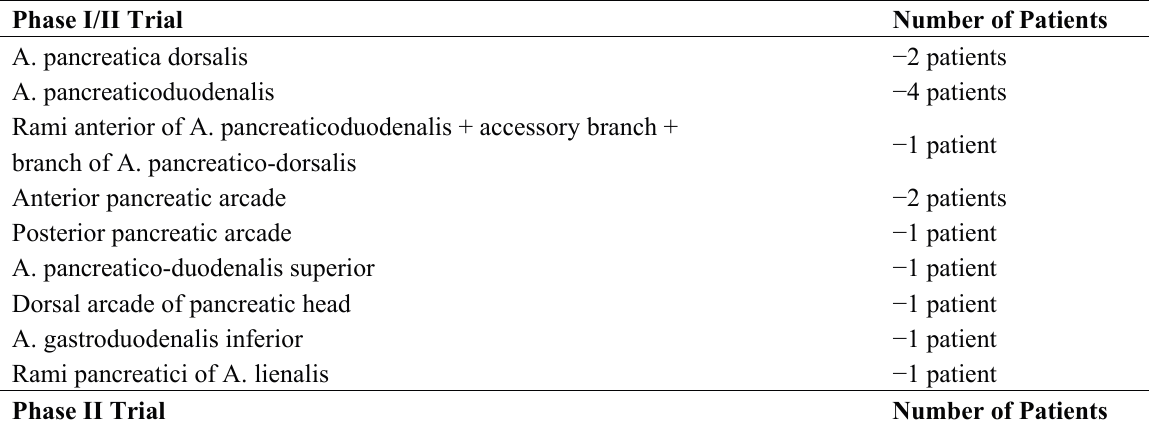
Table 1. Vessels targeted for encapsulated cell instillation.